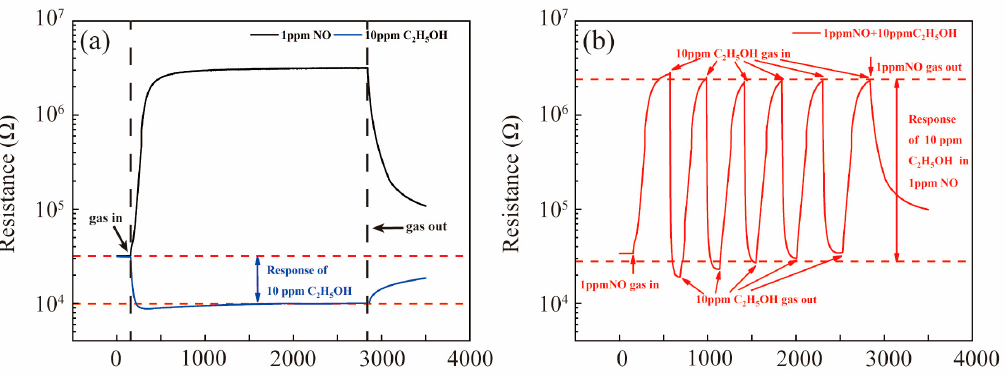
Figure 6. Response of Pt-SnO 2 to 10 ppm C 2 H 5 OH ( a ) in dry air and ( b ) in 1 ppm NO.